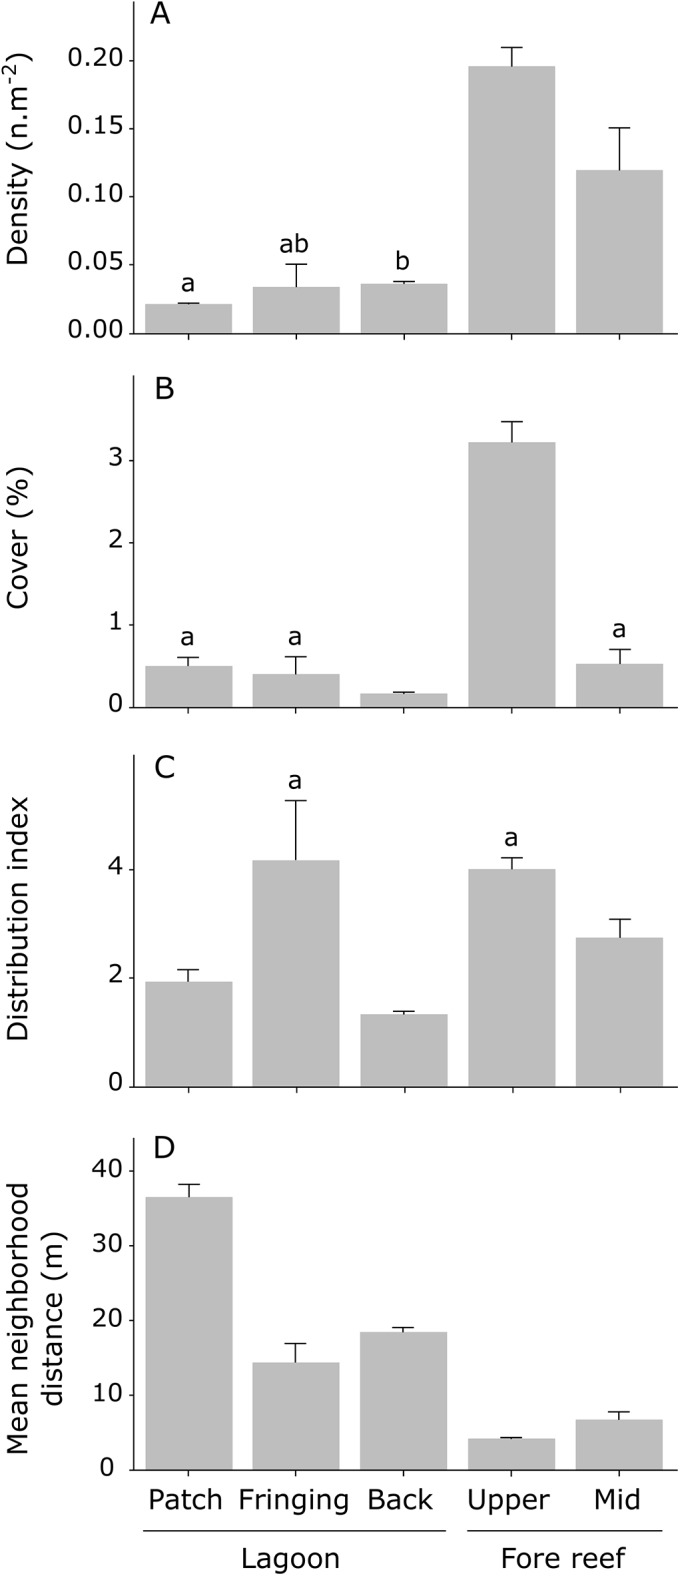
Index describing the spatial distribution of Millepora platyphylla colonies across the five surveyed habitats.(A) Density (B) cover (C) distribution index and (D) mean neighborhood distance. Values were average per habitat and error bars show the standard error for transect replicates. Similar letters indicate no statistical difference in post-hoc comparisons among habitats (P > 0.5).